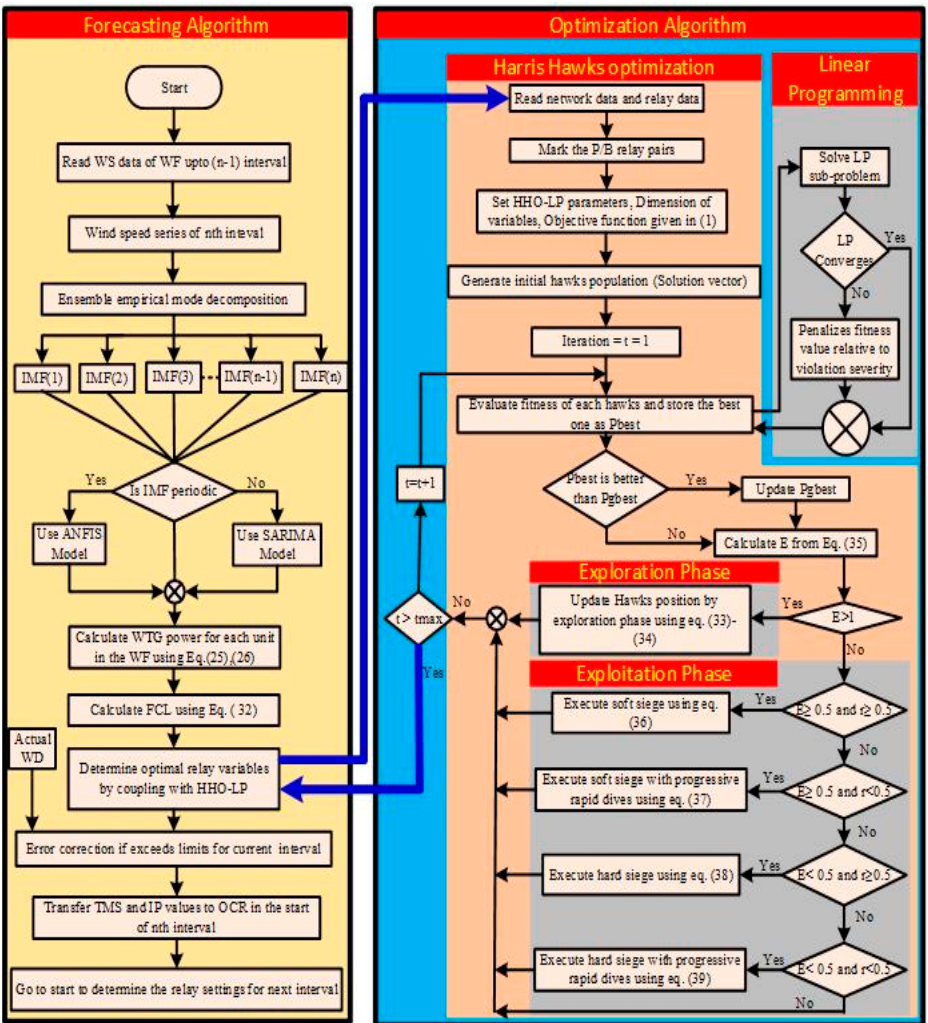
Figure 6. The hybrid ANFIS–seasonal autoregression integrated moving average (SARIMA) forecasting algorithm coupled with the hybrid Harris hawks optimization and linear programming (HHO–LP) optimization algorithm.